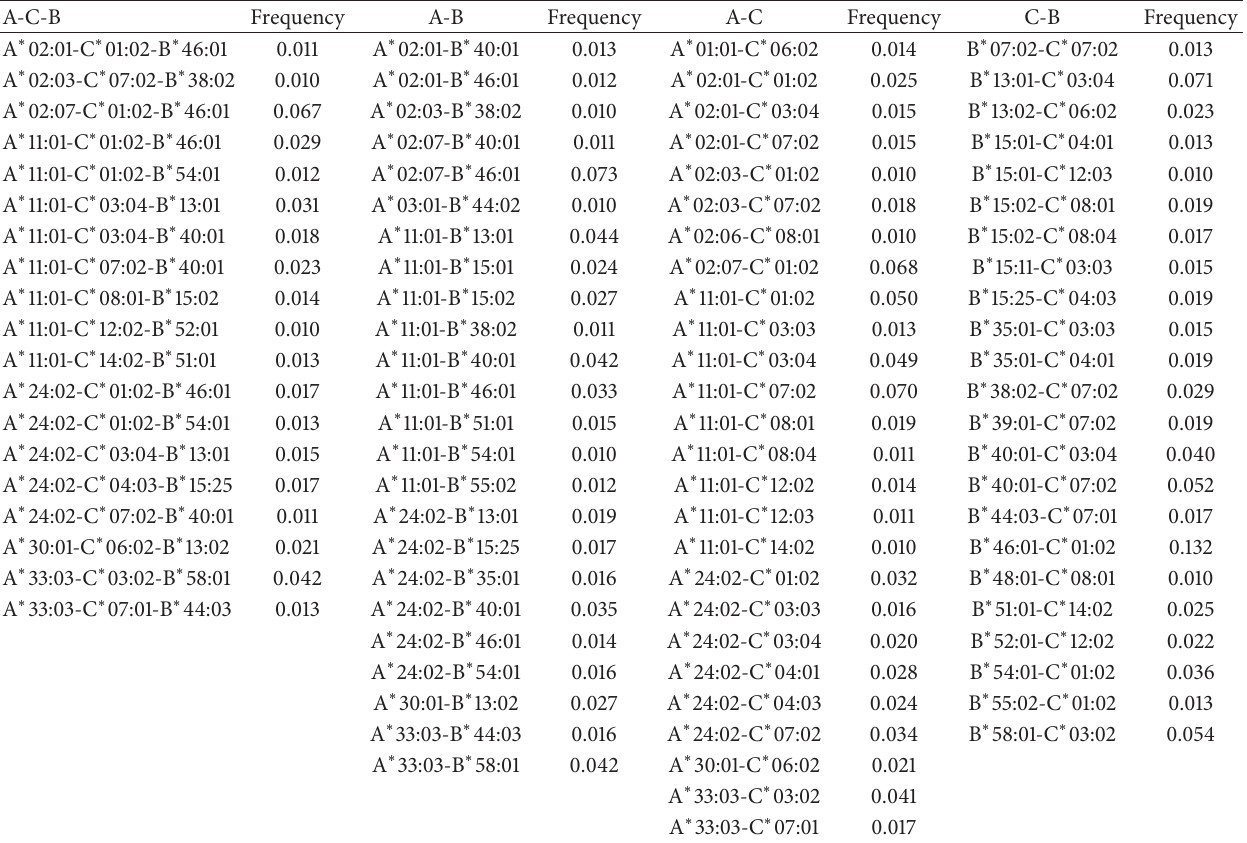
Table 4: Common HLA A-C-B, A-B, A-C, and B-C haplotypes in Yunnan Han.